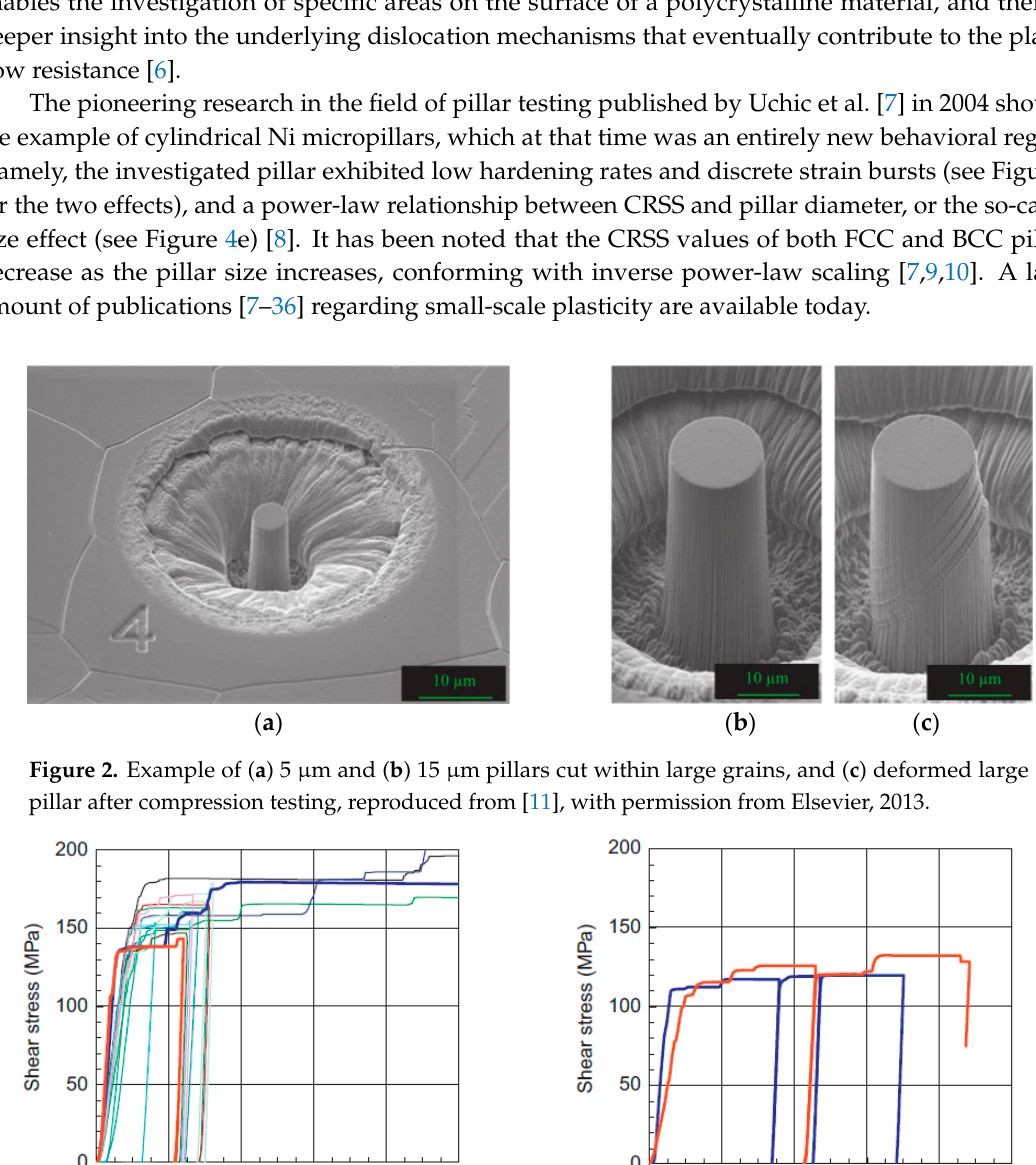
Figure 3. Resolved shear-stress vs. strain curves of ( a ) 5 µm pillars and ( b ) 15 µm pillars, reproduced from [11], with permission from Elsevier, 2013.